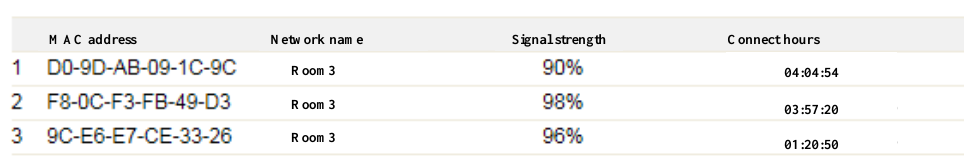
Figure 3. Access point administration page.